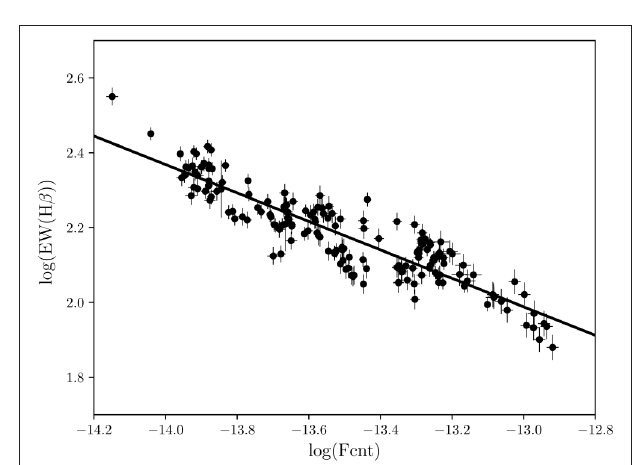
FIGURE 3 | The intrinsic Baldwin effect, i.e., the H β line equivalent width vs. the continuum flux at 5100 Å, in case of Seyfert 1 galaxy NGC